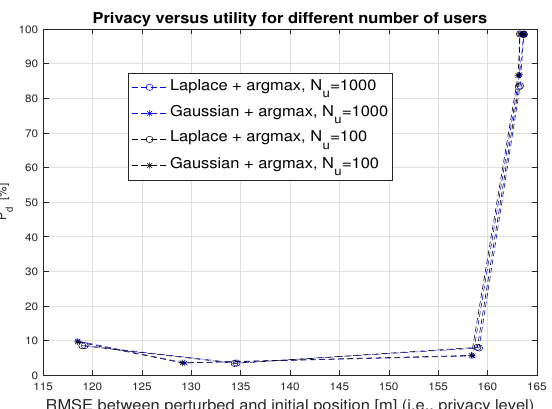
Figure 16. Privacy versus utility tradeoff in the presence of different number of users. Argmax metric and γ = 2